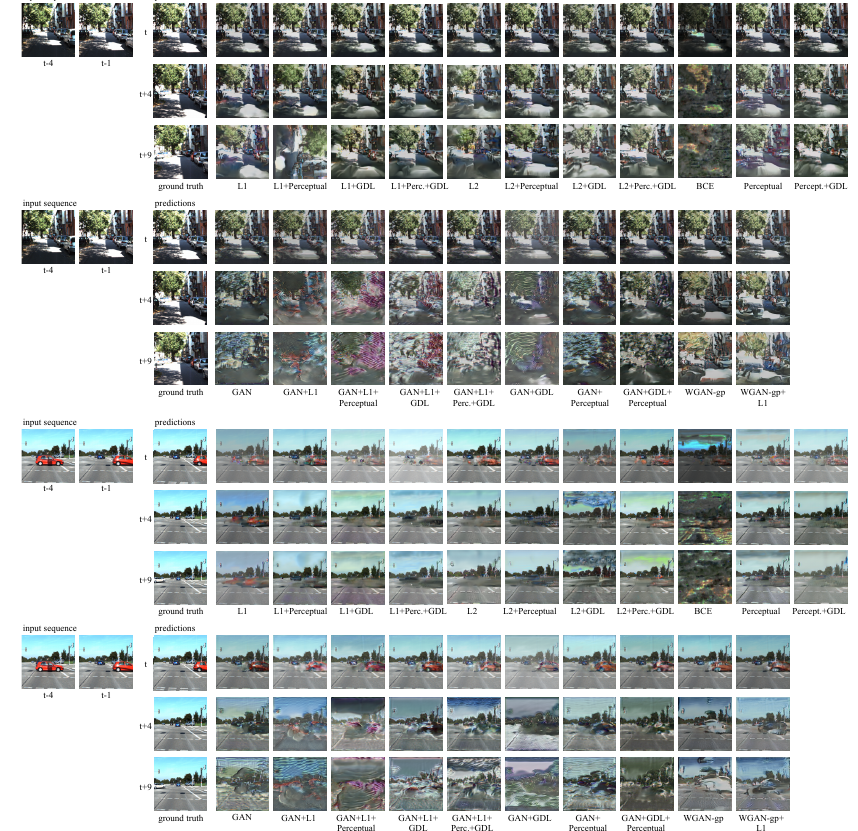
Figure A5. Qualitative results for the KITTI Tracking test split. To generate these images, we used the models that were trained on Cityscapes for 20 epochs. The models were trained to predict the next frame based on four past frames. All images are included in the supplementary material. (The images are best viewed on